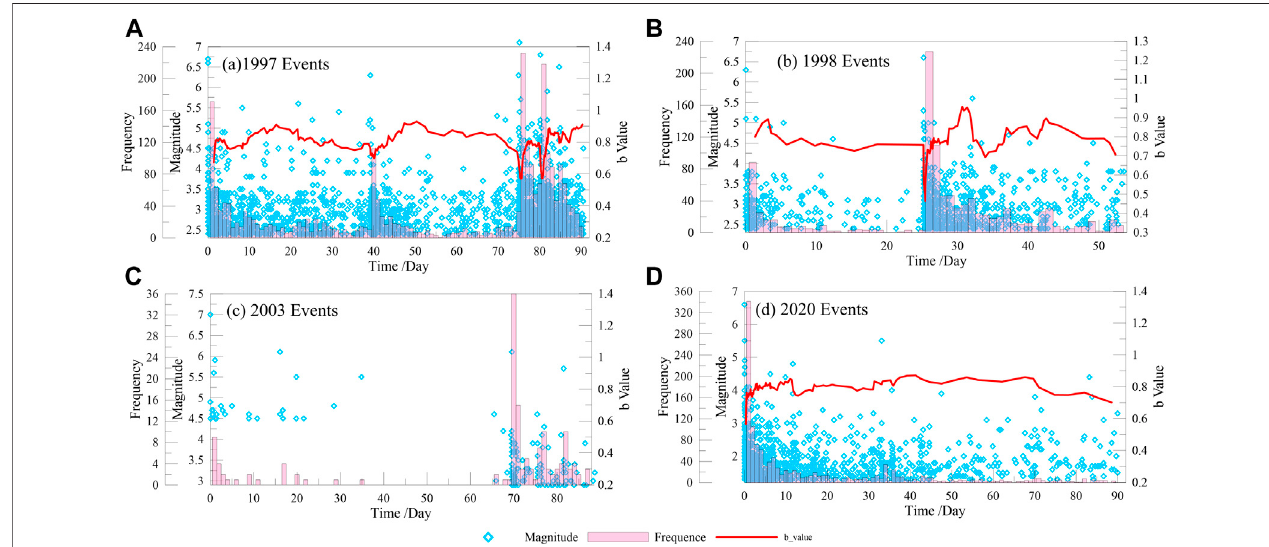
FIGURE 6 | Magnitude – time (M – T), frequency, and b -value evolution diagrams of the sequences of the 1997 Jiashi strong-earthquake swarm, the 1998 Jiashi double earthquake, the 2003 Bachu-Jiashi earthquake, and the 2020 M6.4 Jiashi earthquake. The blue dots represent shocks. The red histogram shows the daily frequency of M C . The red solid line shows the b -value of the